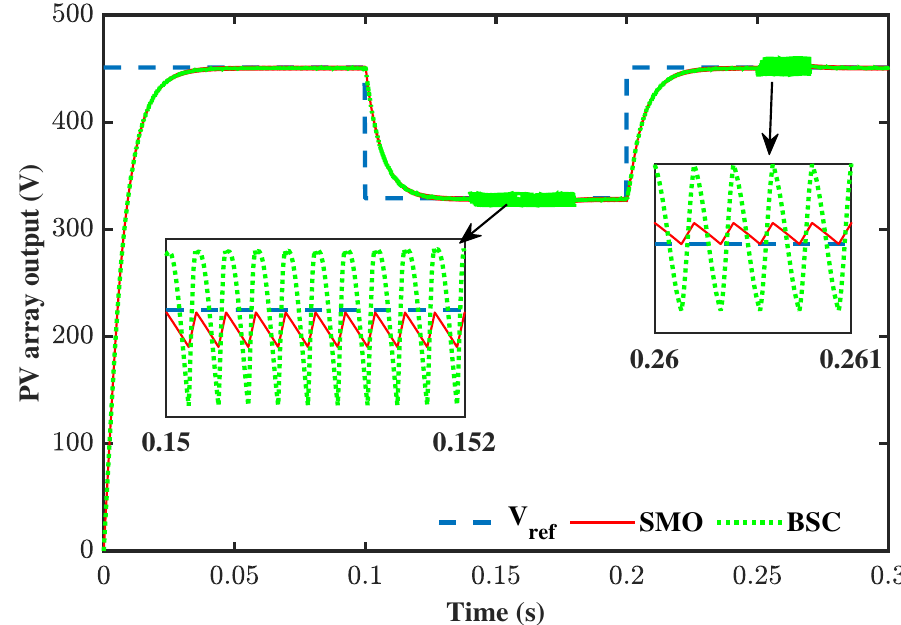
Figure 8. Fault effect on sensor x 1